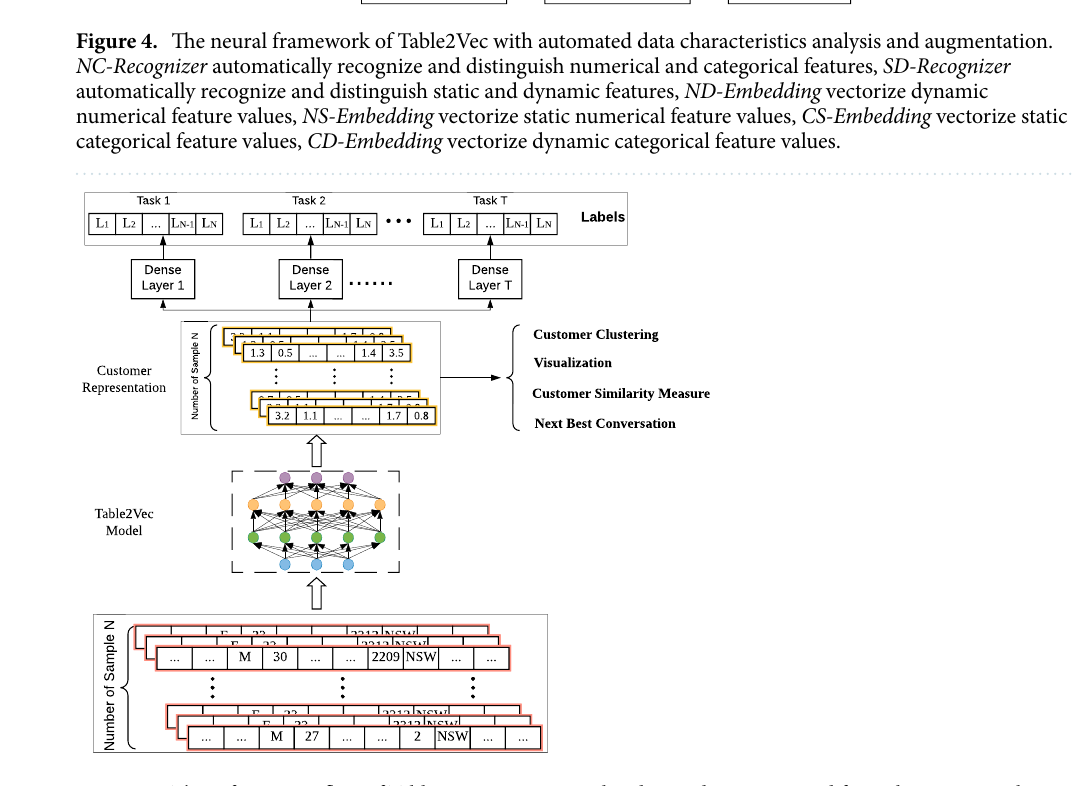
Figure 5. The information flow of Table2Vec. Customer-related records are extracted from the enterprise big data table, on which Table2Vec learns a representation of each customer; the learned customer representation can be used for business problem-specific applications or be further transformed to support learning